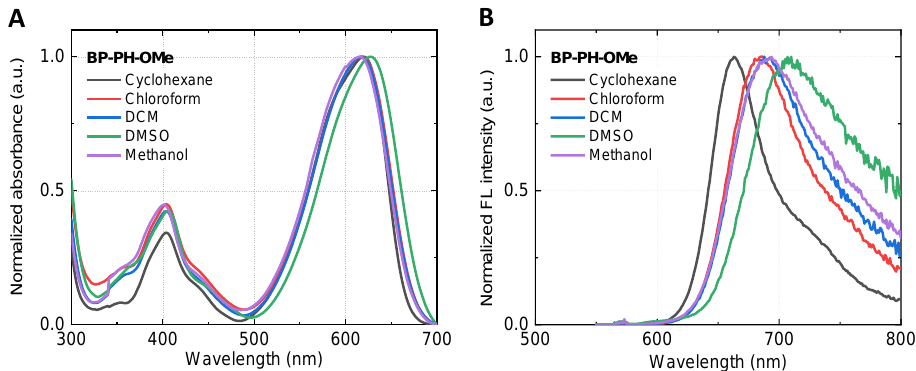
Figure 5. Absorbance ( A ) and fluorescence emission ( B ) spectra of BP-PH-OMe in various polarity solvents. From non-polar to very polar: cyclohexane (dark grey), chloroform (red), dichloromethane (DCM; blue), dimethyl sulfoxide (DMSO; green), and methanol